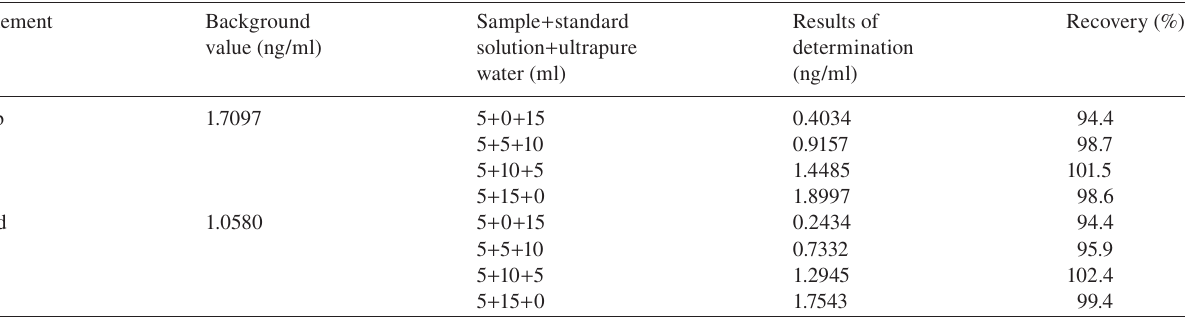
Table 5 Recovery results a